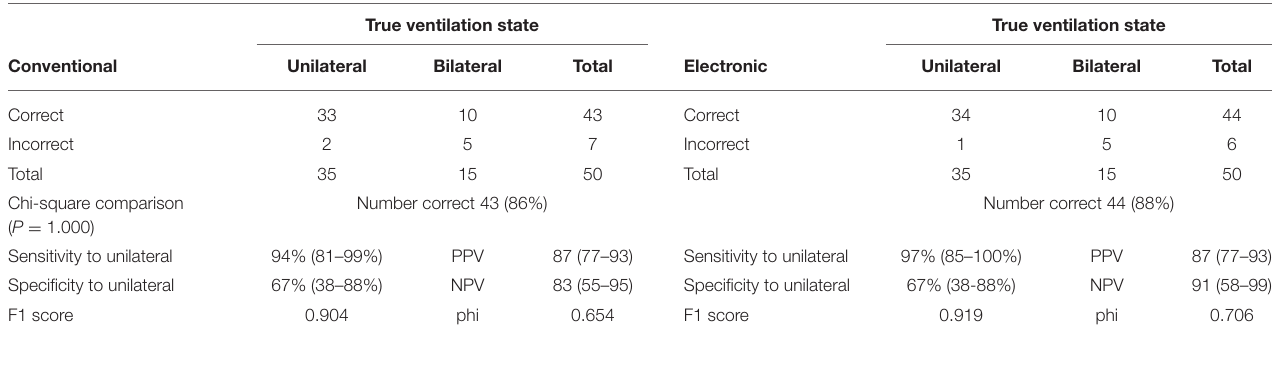
TABLE 2 | Identification of ventilation statuses through conventional and electronic auscultation.